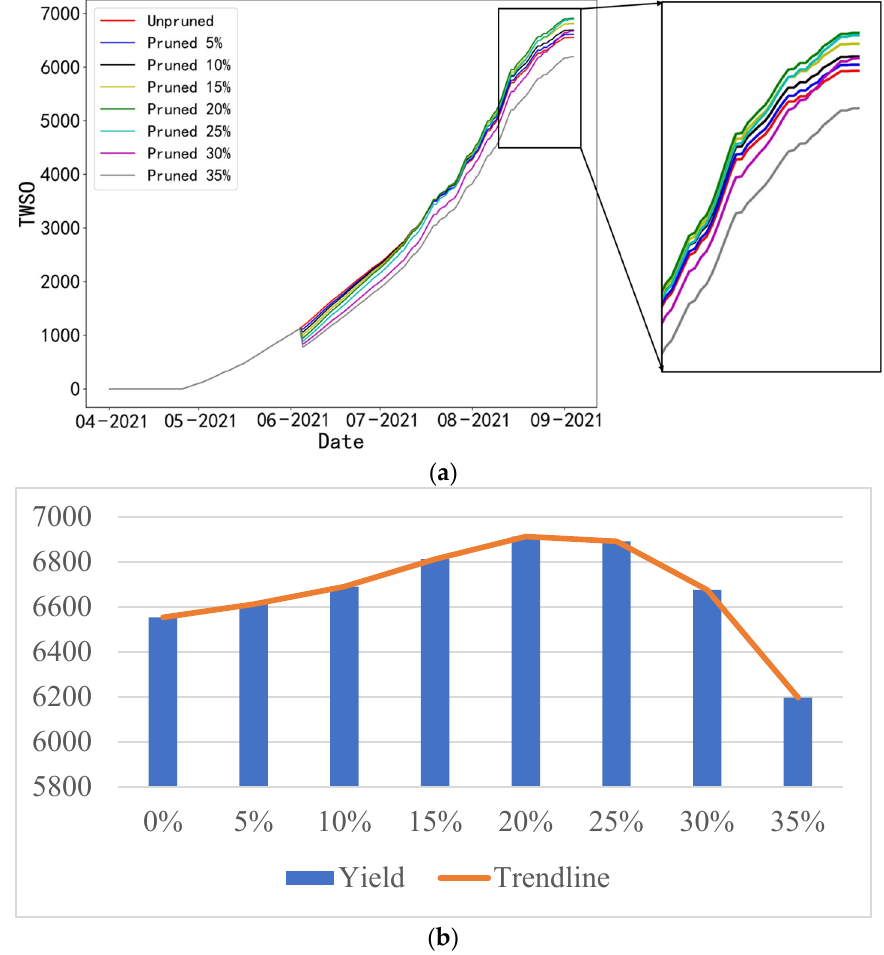
Figure 10. ( a ) Simulated results of final yield with different pruning intensities (Alaer). ( b ) Trends in simulated final yield with different pruning intensities (Alaer) based on modified model.